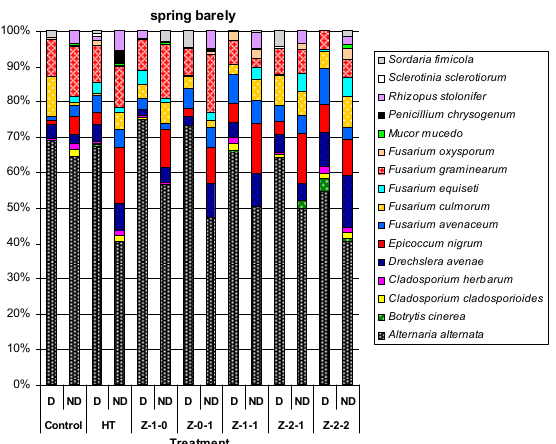
Figure 1. The percentage each species of microscopic fungi cultured for the disinfected (D) and non-disinfected (ND) grains of spring barely, mean for 2010–2012. Mucor mucedo Fresen. and Penicillium chrysogenum Thom were isolated only from non-disinfected (ND) grains.